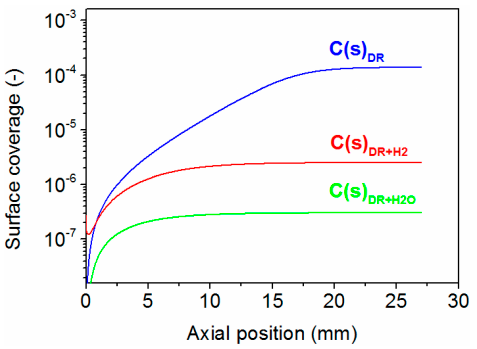
Figure 16. Computed surface coverage for carbon along the catalytic bed for methane reforming with CO 2 at 1123 K: ( a ) comparison of methane dry reforming without and with H 2 , and H 2 O co-feed